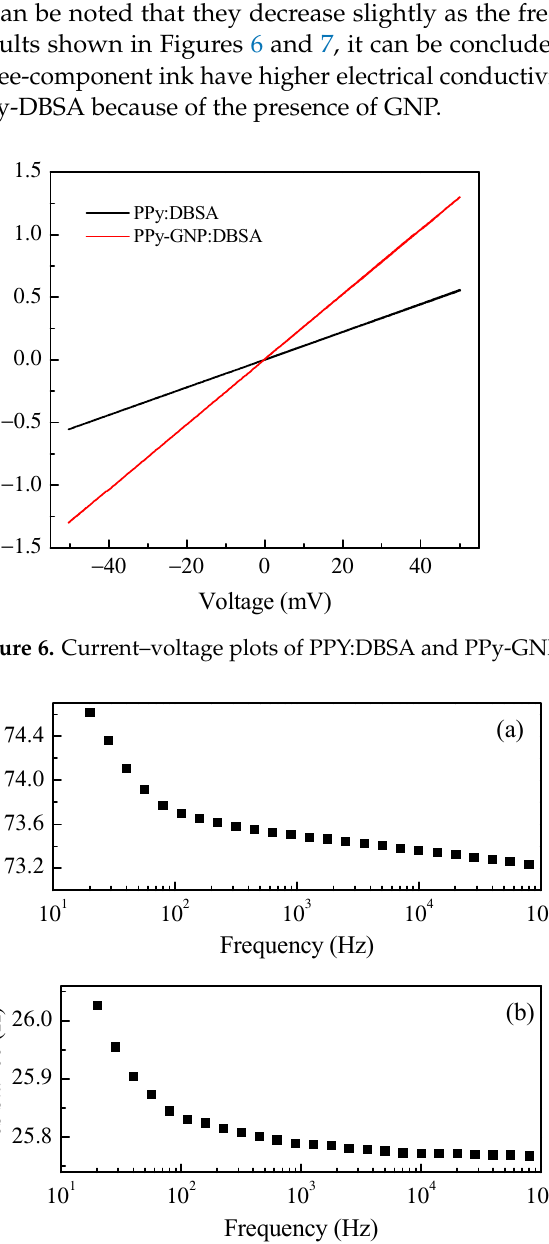
Figure 7. Frequency dependence of the real part of the impedance of a PPY:DBSA film ( a ) and of a PPy-GNP:DBSA film ( b ). The imaginary part of the impedance is negligible in both cases at all of the explored frequencies.